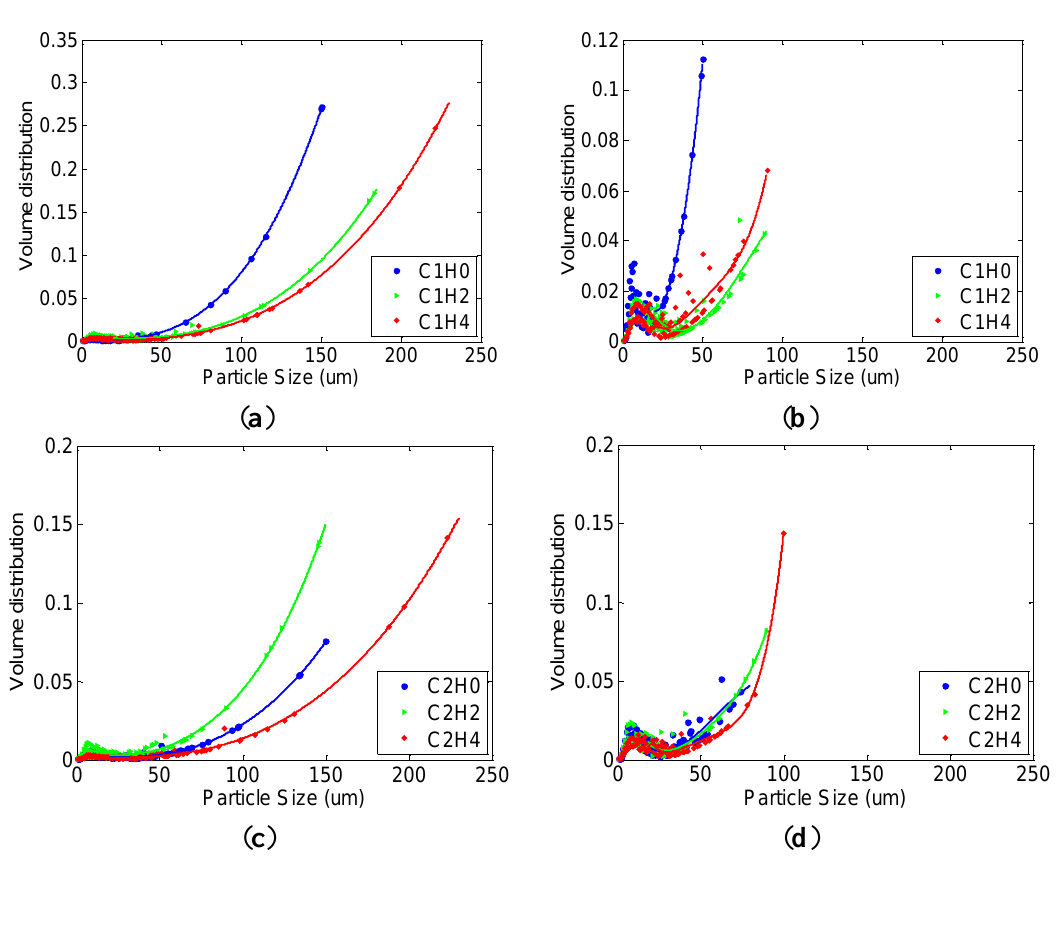
Figure 8. Volume distributions of mixes C1 to C5 ( a ) mix C1 at 500 RPM; ( b ) mix C1 at 900 RPM; ( c ) mix C2 at 500 RPM; ( d ) mix C2 at 900 RPM; ( e ) mix C3 at 500 RPM; ( f ) mix C3 at 900 RPM; ( g ) mix C4 at 500 RPM; ( h ) mix C4 at 900 RPM; ( i ) mix C5 at 500 RPM; ( j ) mix C5 at 900